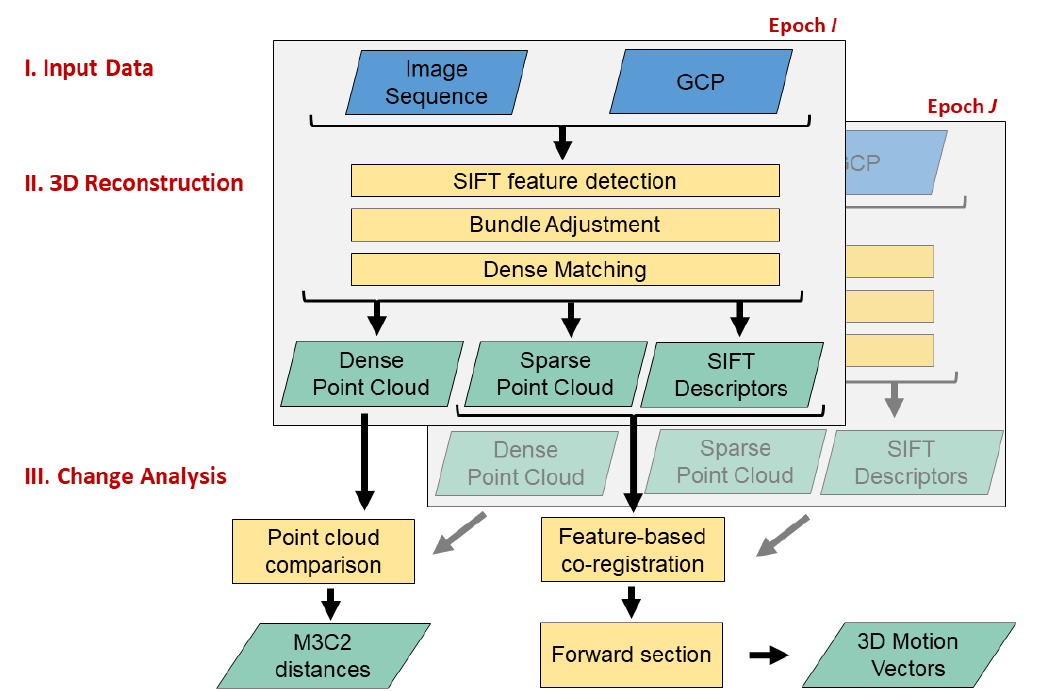
Figure 2. Workflow for the photogrammetric monitoring of rock slope